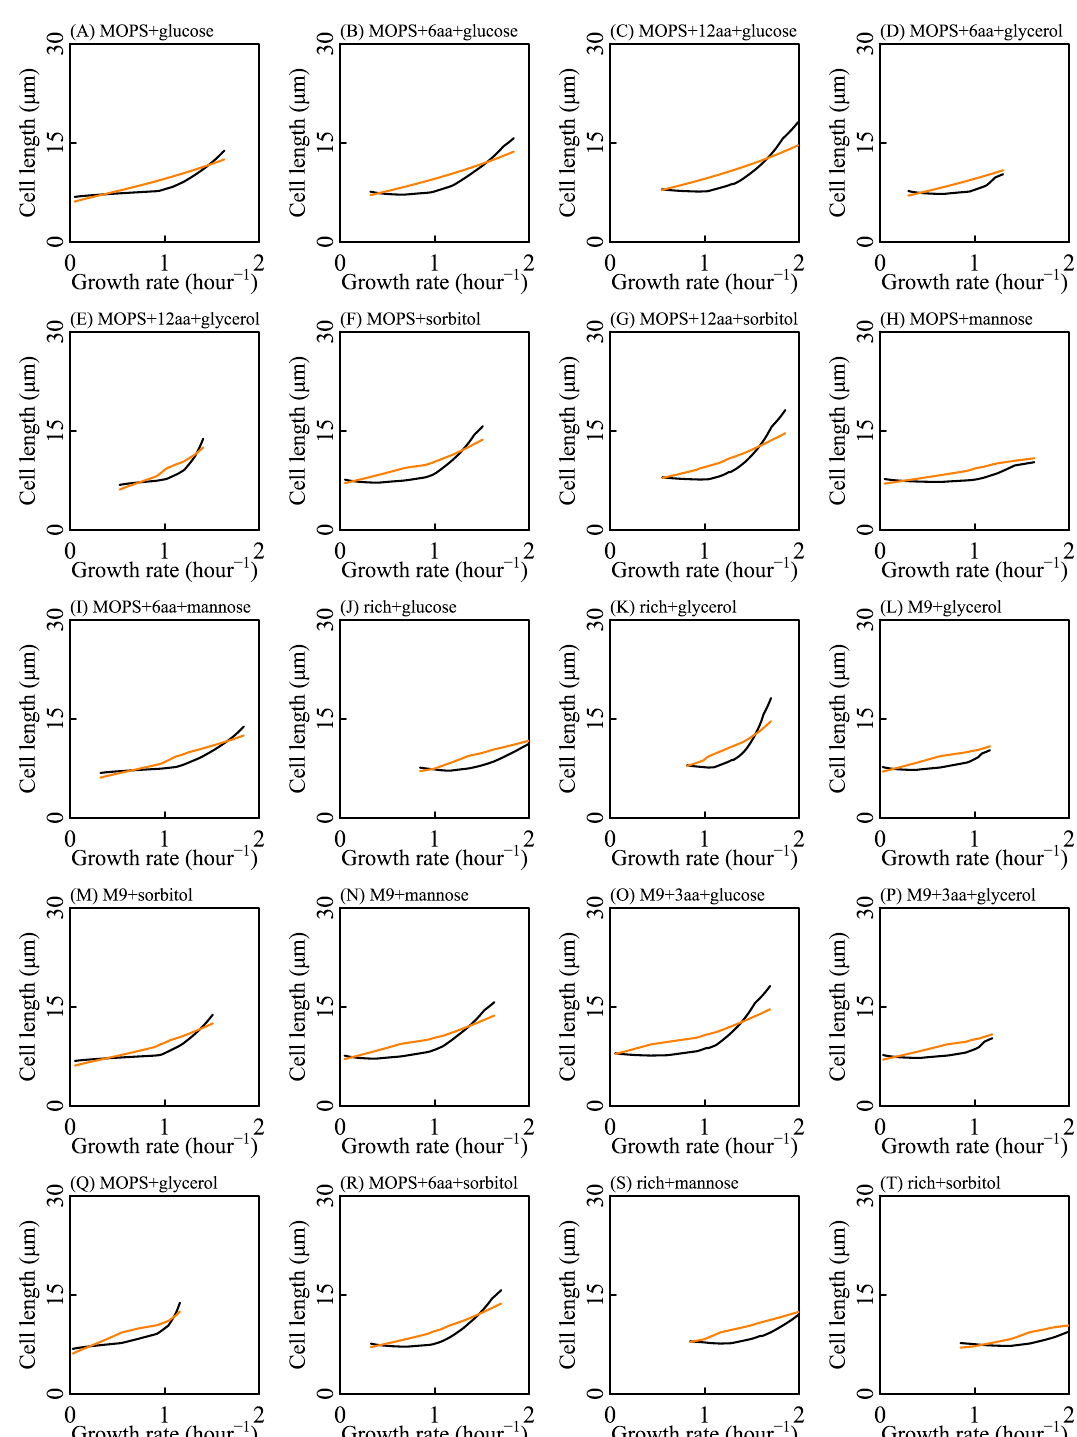
Figure A5. Effects of cell width on cell length. The solid lines in both black and orange are cell length. The difference between them is whether the variation of cell width is derived from the fraction area of phospholipid in membranes ( f l ) or from the amount of phospholipid in cell caps ( n 0 ). As for black solid lines, f l is based on the simulations, which varies with the growth rate, while n 0 is constant. As for orange solid lines, f l uses the average value, which does not change with the growth rate, while n 0 changes with the growth